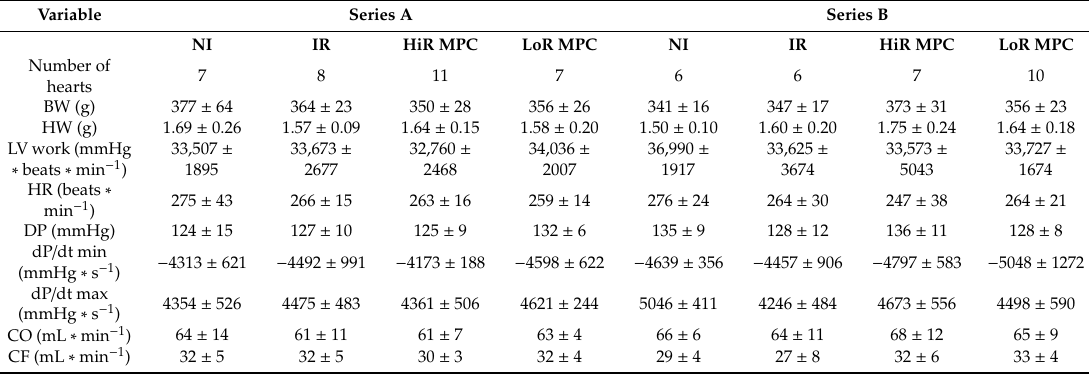
Table 1. Baseline characteristics Series A and B. BW, body weight; CF, coronary flow; CO, cardiac output; DP, developed pressure; dP / dt max, maximum first derivative of LV pressure; dP / dt min, minimum first derivate of LV pressure; HiR, high recovery; HR, heart rate; HW, heart weight; IR, ischemia reperfusion; LoR, low recovery; LV work, left-ventricular work (HR-DP product); MPC, mechanical postconditioning; NI, no ischemia. Data are expressed as mean ± standard